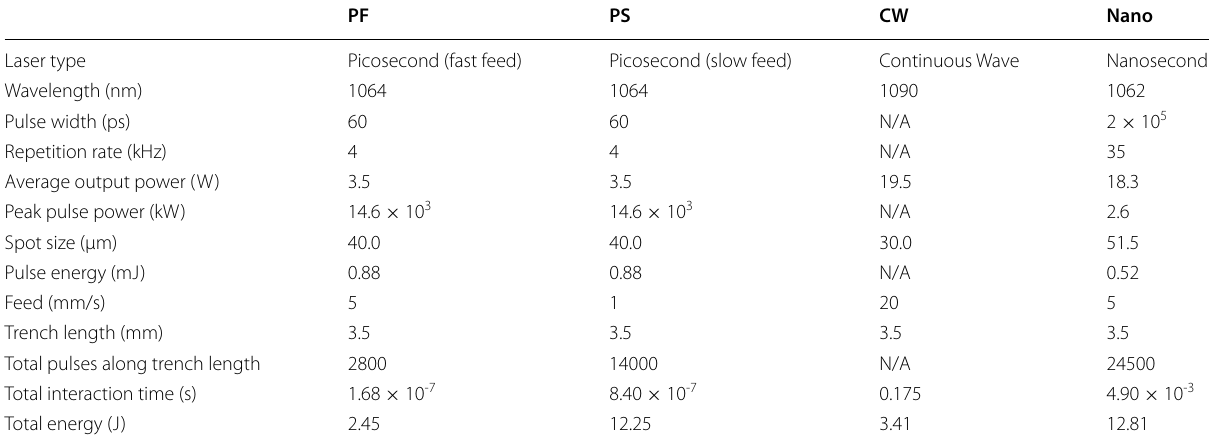
Table 1 Laser machining parameters for necrosis